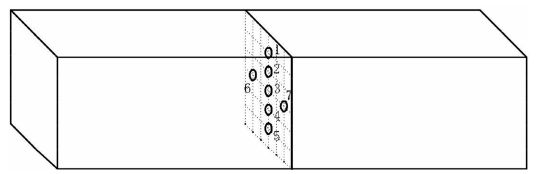
Figure 2. Test material and temperature measurement point.